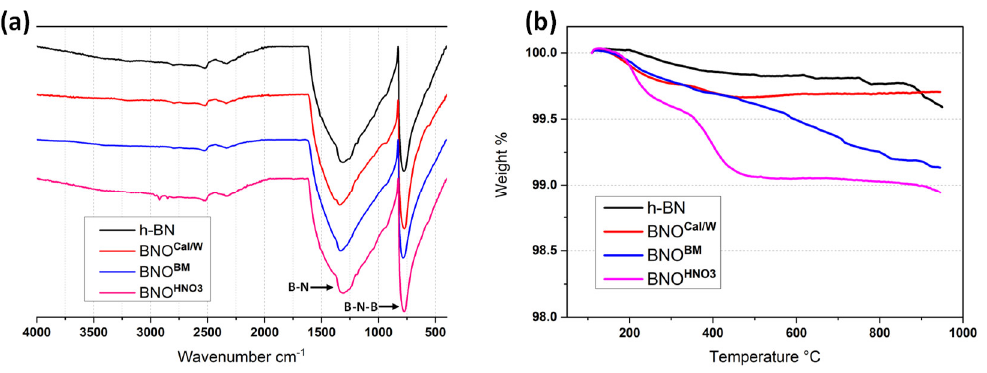
Figure 4. ( a ) FTIR spectra and ( b ) TGA thermograms of hydroxylated BNO with different methods.